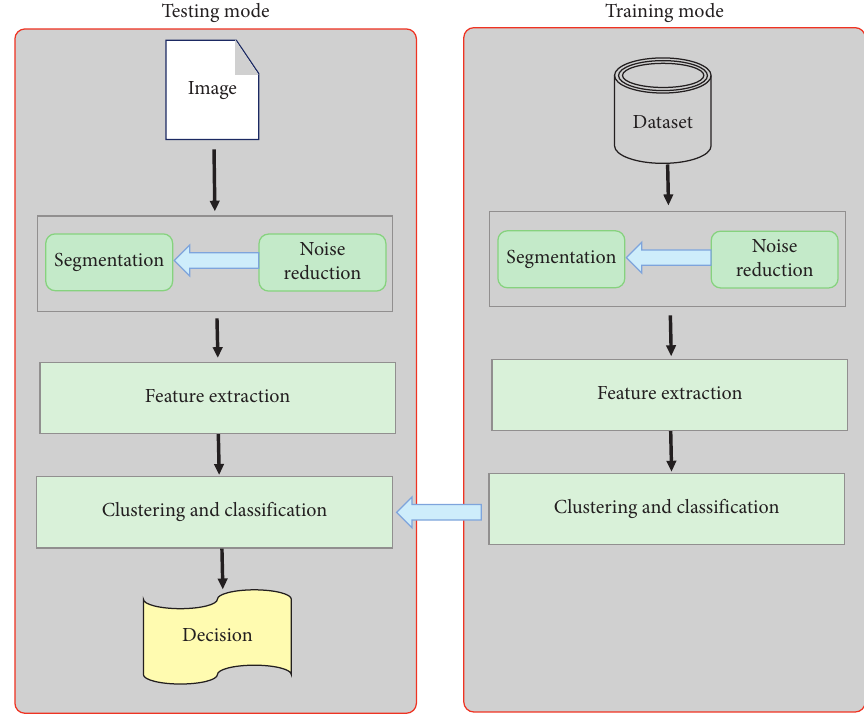
Figure 6: General flowchart of the proposed system.